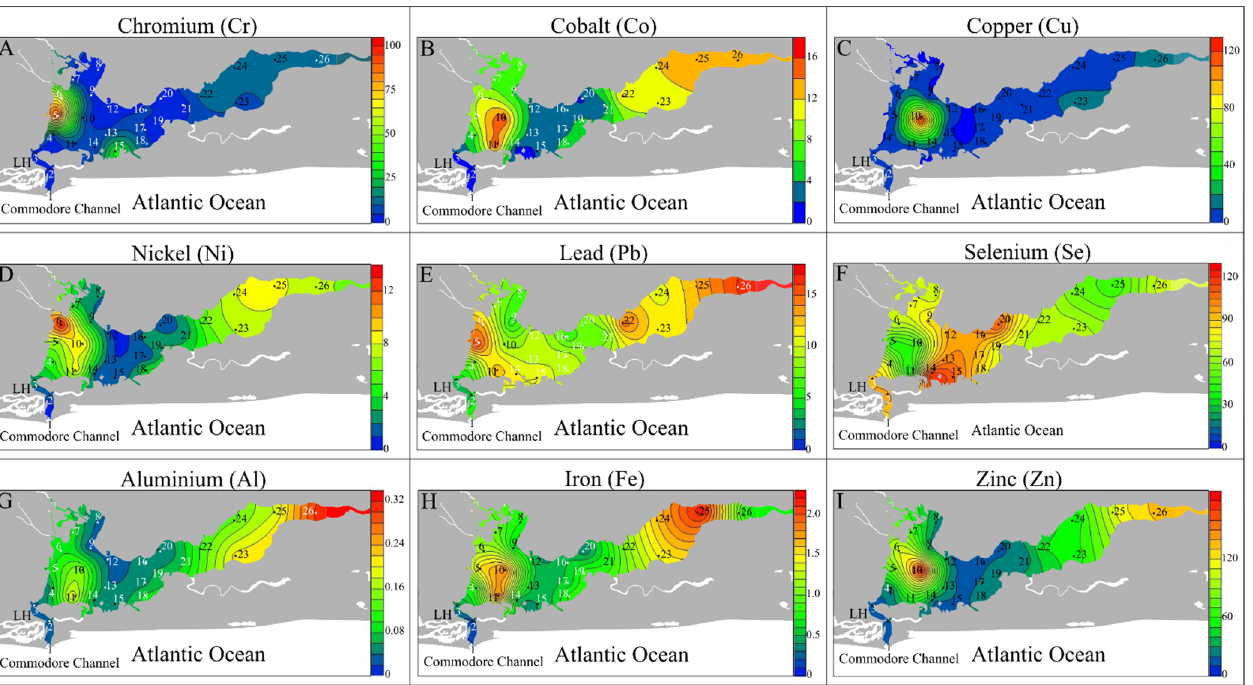
Figure 5. Heat maps showing the spatial distribution and total concentration of PTEs across the Lagos Lagoon. ( A ): Chromium (Cr), ( B ): Cobalt (Co), ( C ): Copper (Cu), ( D ): Nickel (Ni), ( E ): Lead (Pb), ( F ): Selenium (Se), ( G ): Aluminum (Al), ( H ): Iron (Fe), ( I ): Zinc (Zn). All concentrations are in mg/kg except for Al and Fe which are in percent. LH (Lagos Harbour).